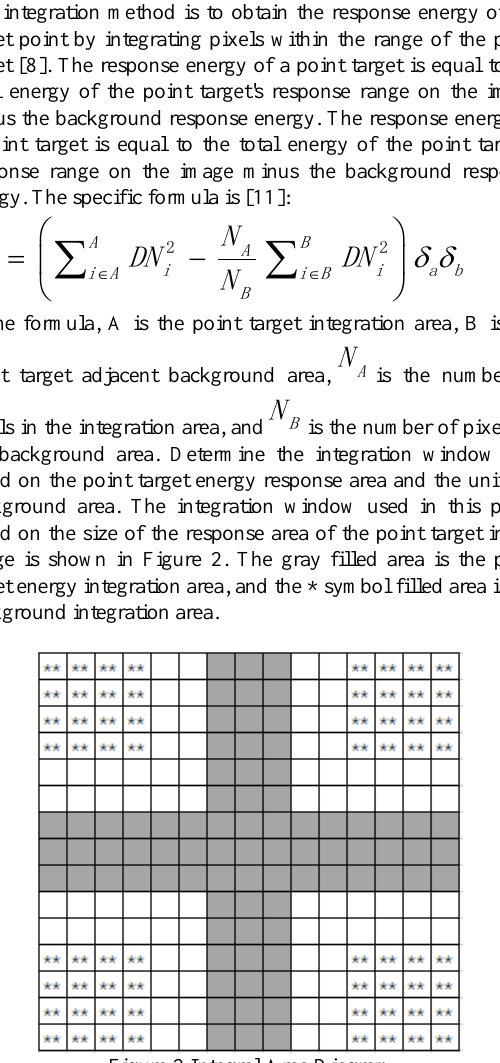
Figure.2 Integral Area